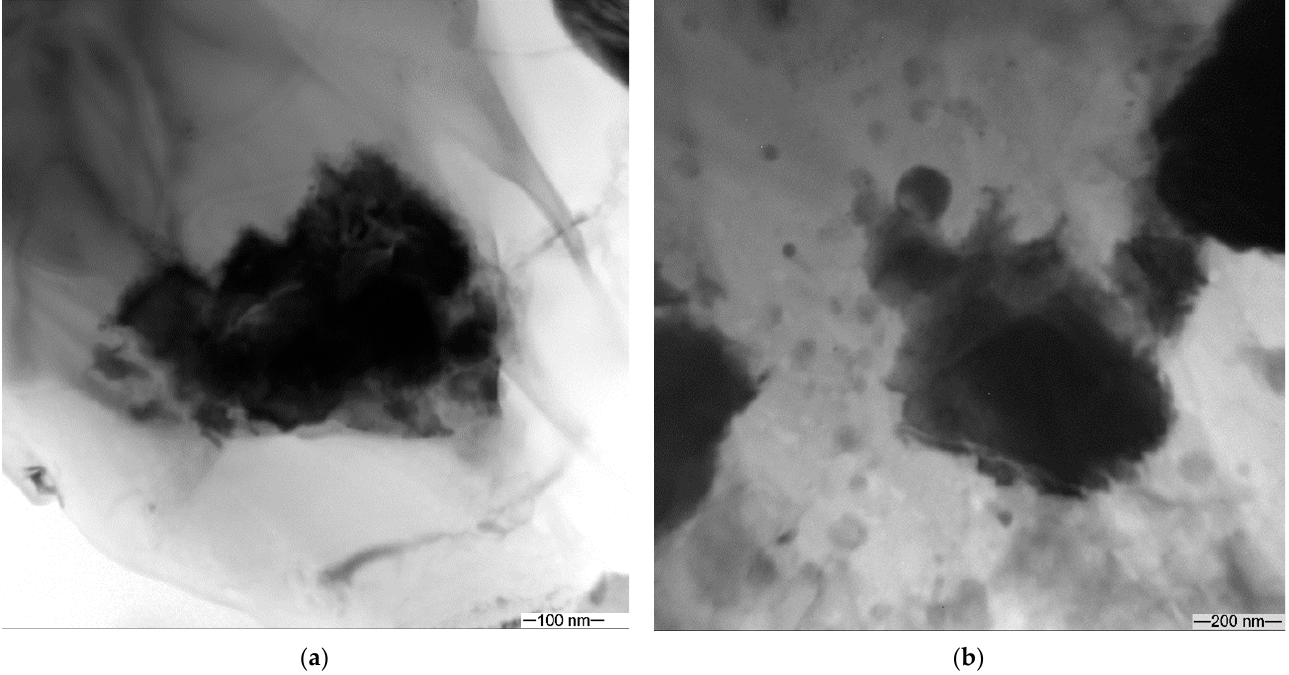
Figure 14. TEM image of particle resulted from decomposition of ZrW 2 O 8 ( a ) and vacancy condensation loops around such a particle ( b ).